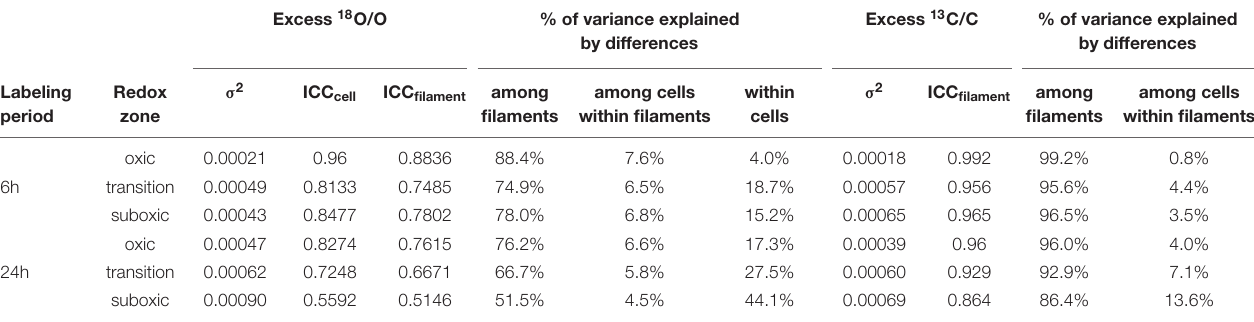
TABLE 4 | Structure of the variance in the 18 O labeling of poly-P granules and 13 C labeling of the cytoplasm in the measured cable bacteria. Labeling period